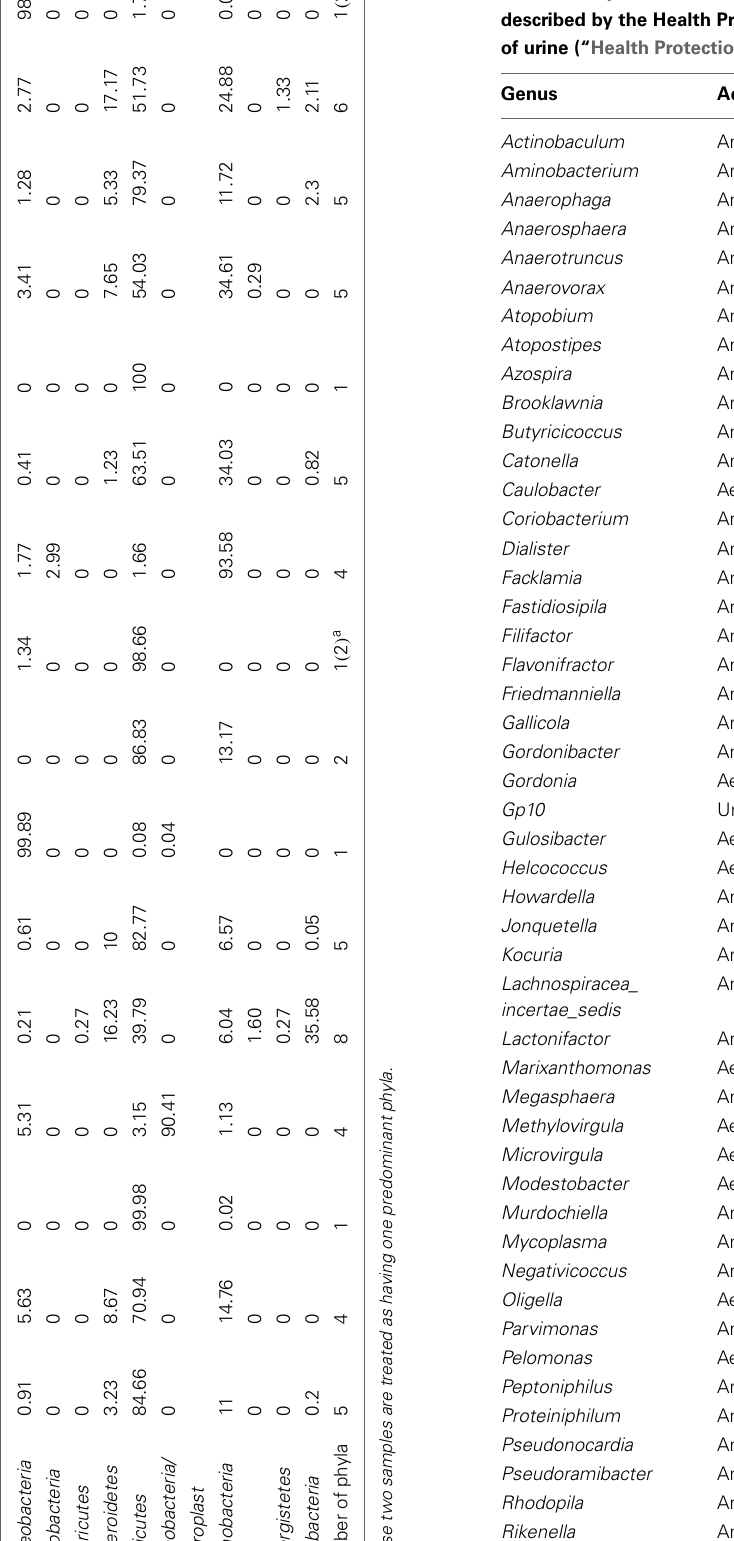
Table A3 | Table listing all the bacteria identified in this study that are not routinely cultivated or reported individually by standard methods described by the Health Protection Agency in routine